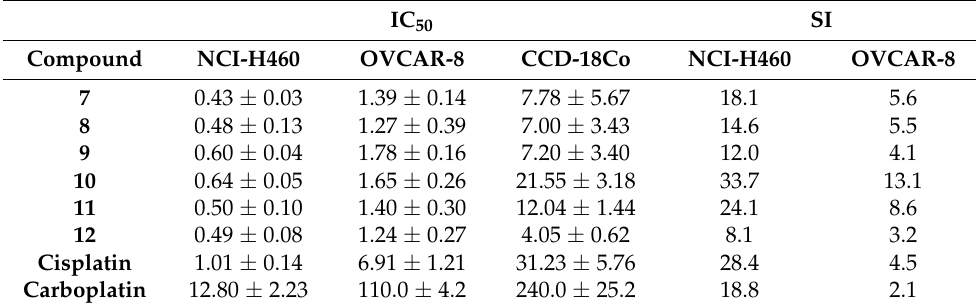
Table 1. IC 50 * values ( µ M) of the tested iron complexes 7–12 on tumor and non-tumor cell lines. IC 50